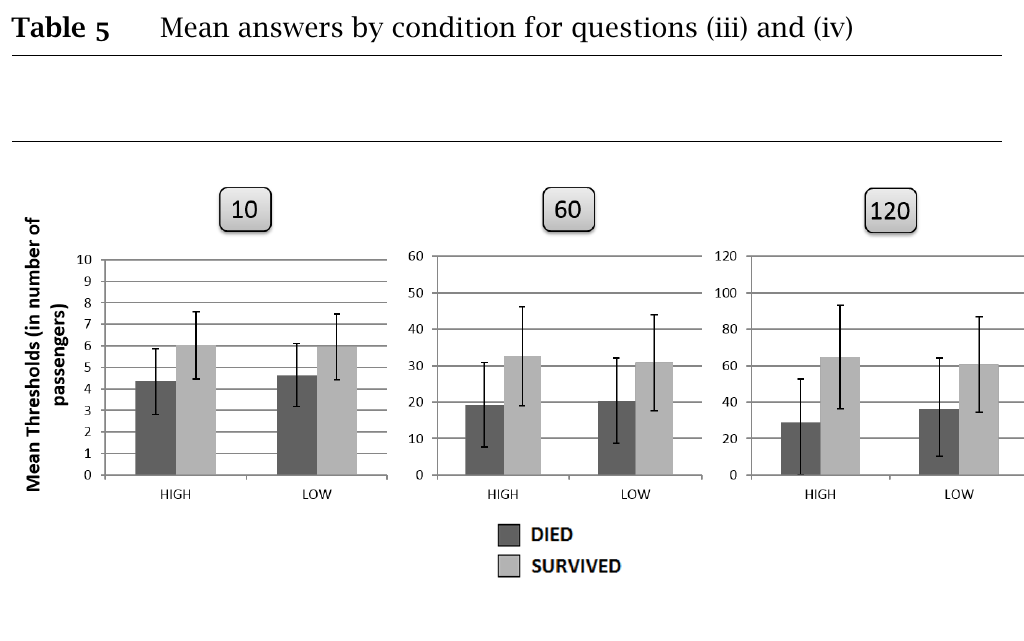
Figure 2 Mean thresholds by question, probability of survival, and total number of passengers. Error bars indicate standard